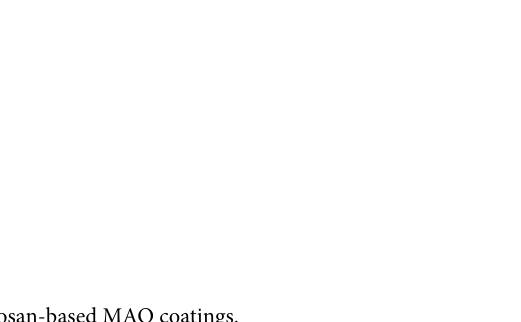
Table 1. EDS spectra results of the MAO and chitosan-based MAO